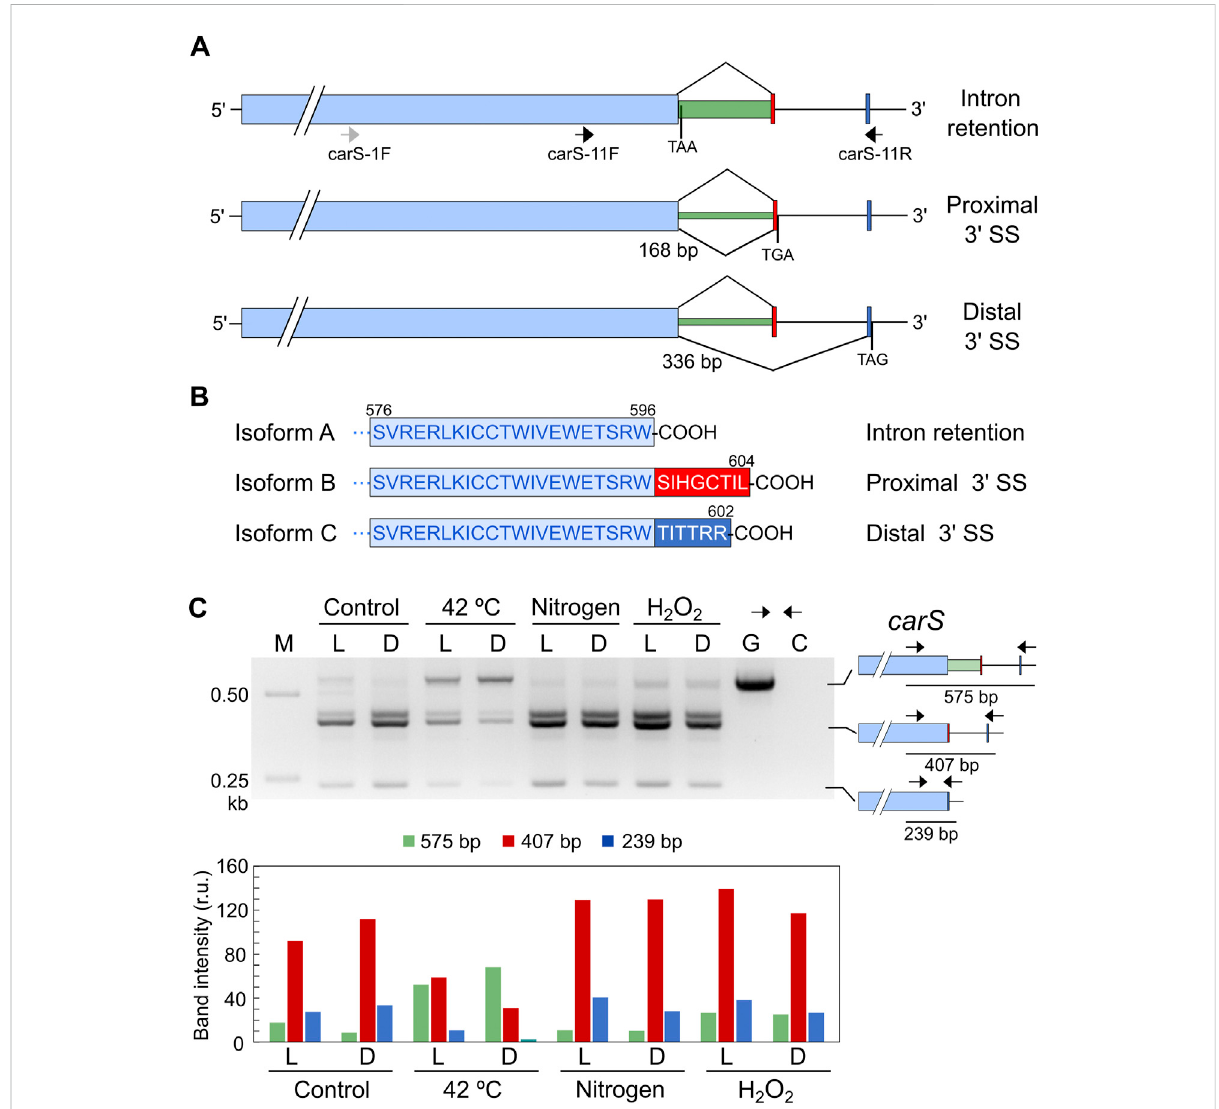
FIGURE 7 Effect ofstressing conditions on splicing of carS mRNA. (A) Isoforms of carS mRNA according to RNA-seq reads. Red and blue bars indicate the mutually exclusive exons fused to the large pale blue exon depending on the splicing event. Arrows indicate primers used in the PCR assays. Stop codonsresultingfromeachmRNAareindicated.Above:intronretention.Middle:splicingofa168-bpintron.Below:splicingofa336-bpintron.Only the relevant carS segment is displayed. (B) Three predicted isoforms of the CarS carboxy end according to the three intron maturation alternatives:intronretention(isoformA),168-bpintronsplicing(isoformB),and336-bpintronsplicing(isoformC). (C) PCRtestofalternativesplicing of carS gene in response to stress. Samples of 25 ml of 3-day-old cultures incubated at 30 ° C in the dark were transferred to Petri dishes and kept under the indicated stress for 1 h in the dark (D) or under illumination (L). Nitrogen starved mycelia (labelled as Nitrogen) were grown for 3 days in medium with 0.625 g/L − 1 NaNO 3 before the transfer to Petri dishes. Oxidative stress was generated incubating mycelia with 16 mM H 2 O 2 for 1 h in the Petri dishes. M, Size markers; G, Genomic DNA; C, Control without cDNA. Molecular interpretation of the PCR products in the three mRNA alternatives is depicted on the schemes on the right. Densitometry analysis of the indicated bands is shown below. Intensity of each band is represented with a different color: green, 575-bp band (intron retention); red, 407-bp band (168-bp spliced intron); blue, 239-bp band (336-bp spliced